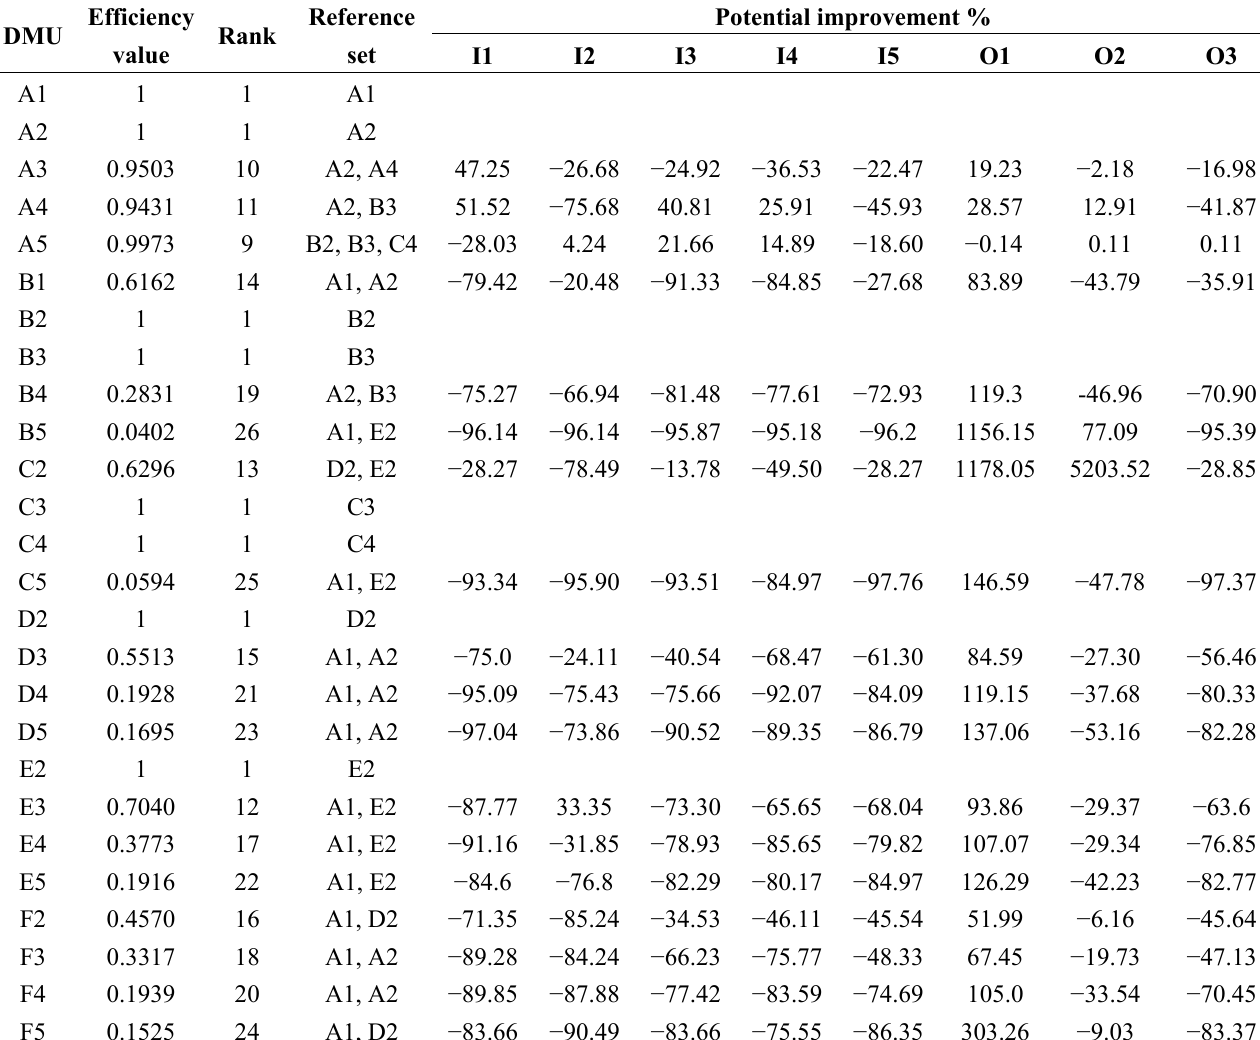
Table 13. Relevant results for AHP/DEA